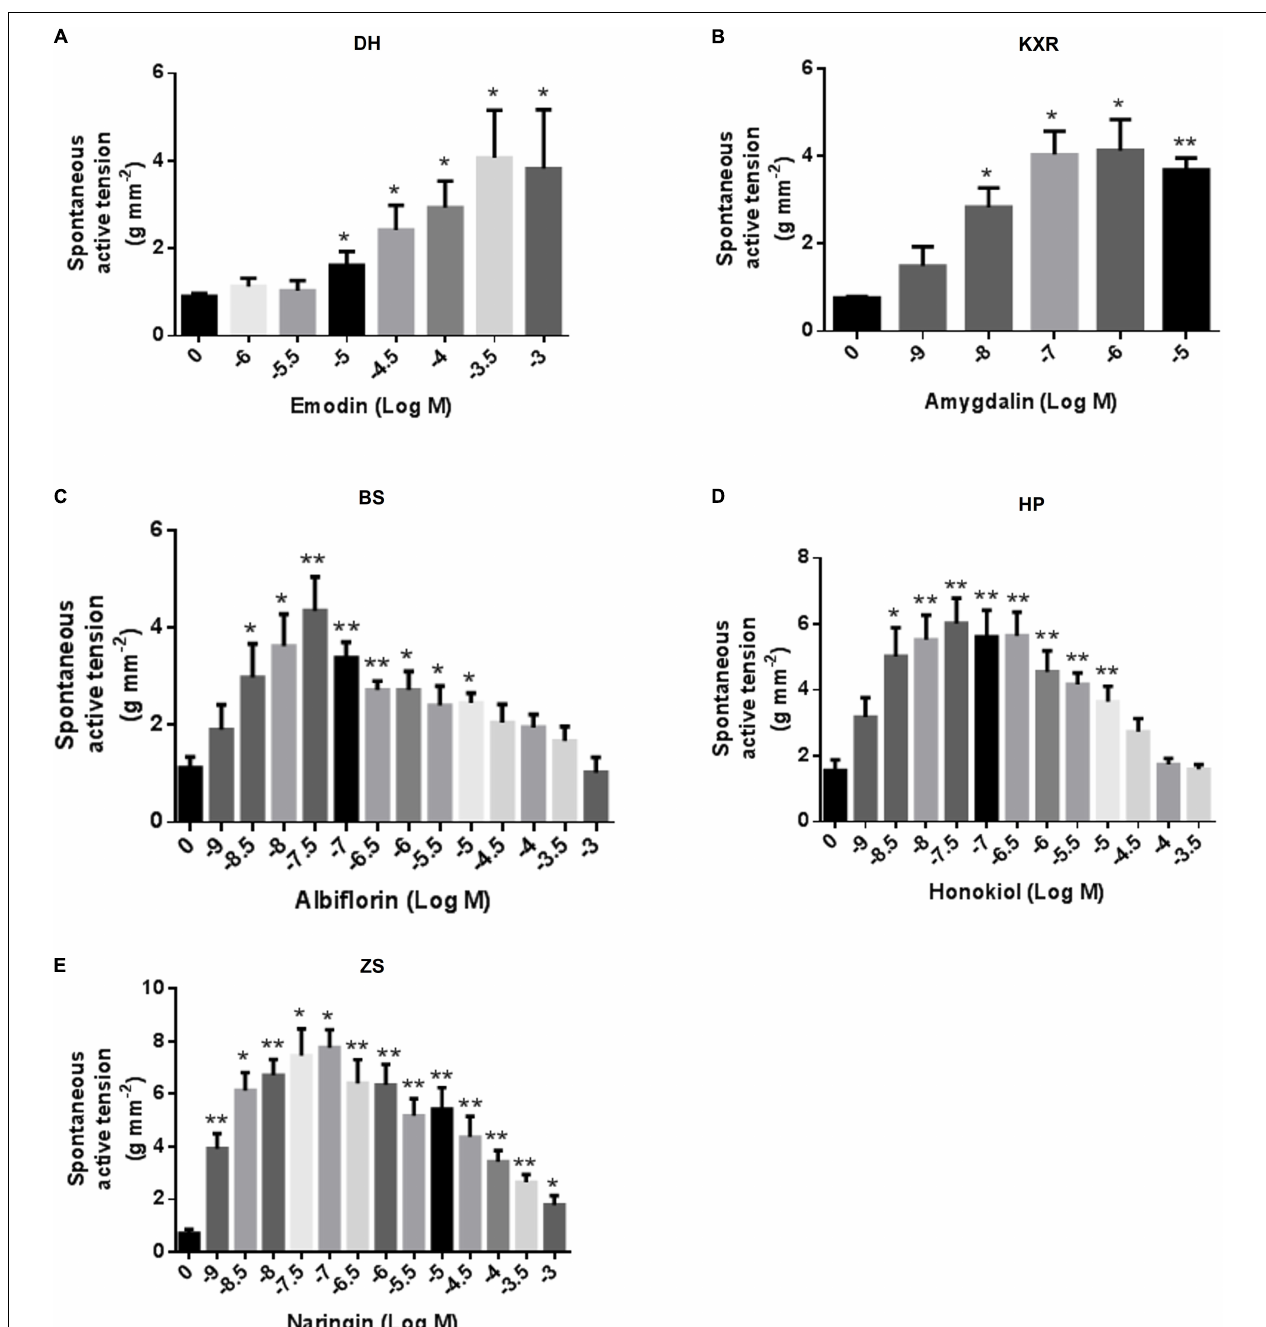
FIGURE 2 | Effects of MZRW representative compounds on spontaneous contraction of colonic smooth muscle in rats in vitro . Effects of emodin (A) , amygdalin (B) , albiflorin (C) , honokiol (D) , and naringin (E) on spontaneous contraction of colonic smooth muscle. Data are mean ± SEM ( n = 4–6). Significant difference is indicated by ∗ P < 0.05 and ∗∗ P < 0.01 compared with